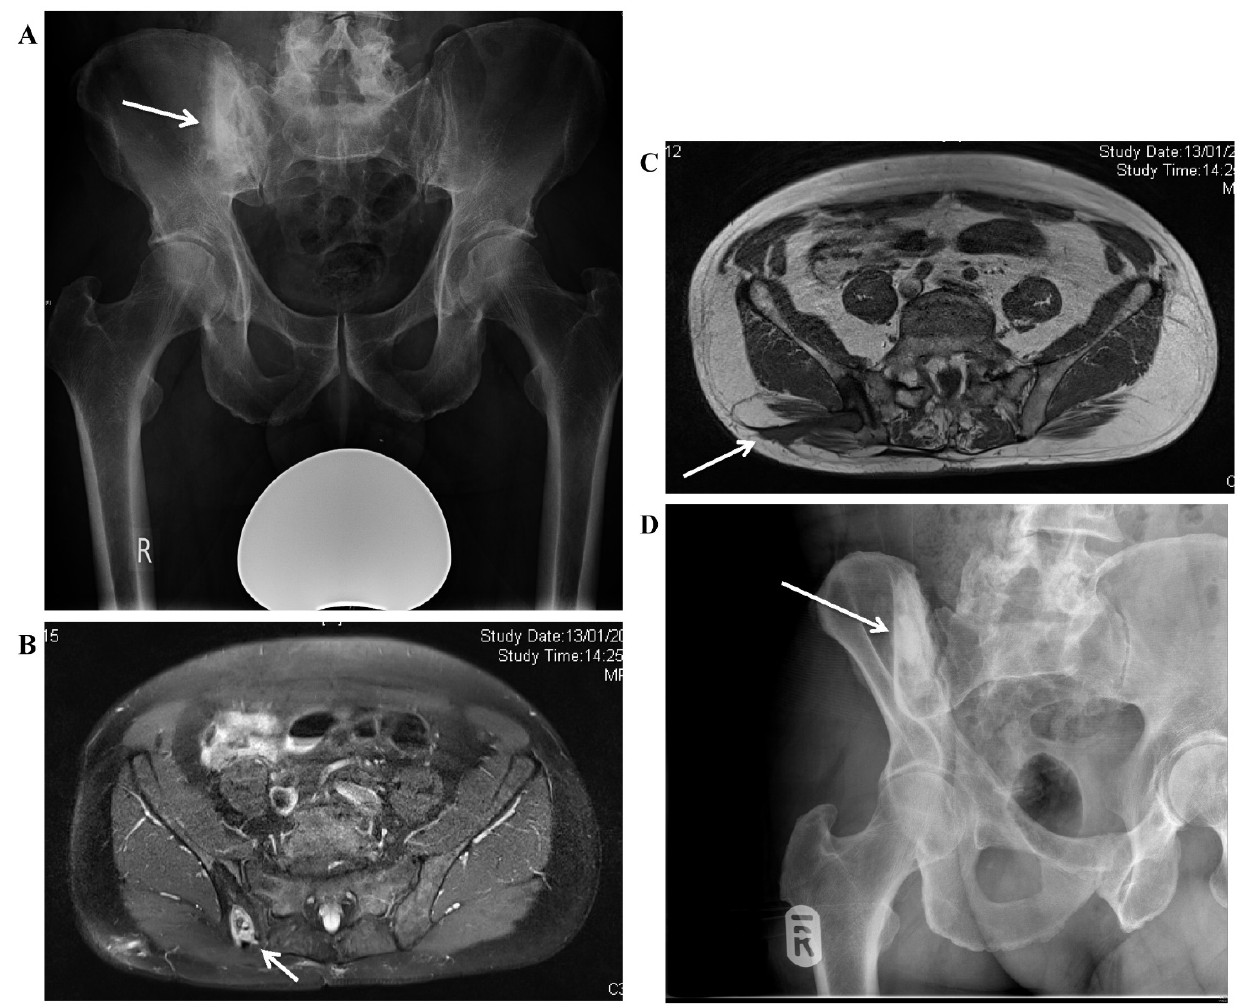
Figure 3. A. Osteomyelitis of the right posterior ilium after a bone graft harvest for a spinal fusion. There is a central cavity with surrounding increased bone density (involucrum). B. MRI showing the bone destruction in the ilium, with a central area of dead bone. C. MRI demonstrating the bone involvement and sinus formation to the skin of the lateral buttock. D. Postoperative radiograph showing the area of resection. The bone defect has been filled with a bioabsorbable antibiotic carrier with Gentamicin (Cerament G, Bonesupport AB, Sweden).